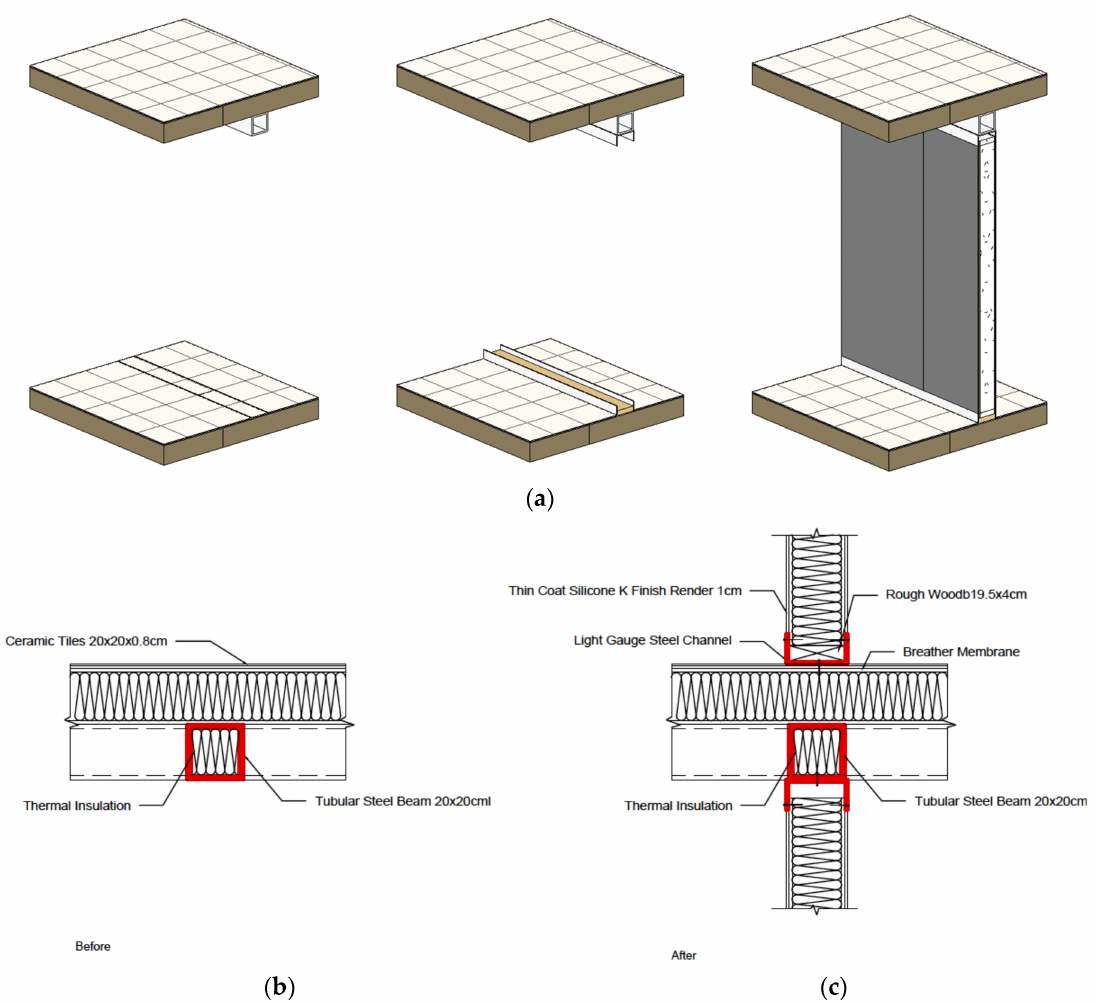
Figure 8. ( a ) A BIM model and ( b , c ) details for a simplified SIP fixation/demounting method for external/internal wall partitions and